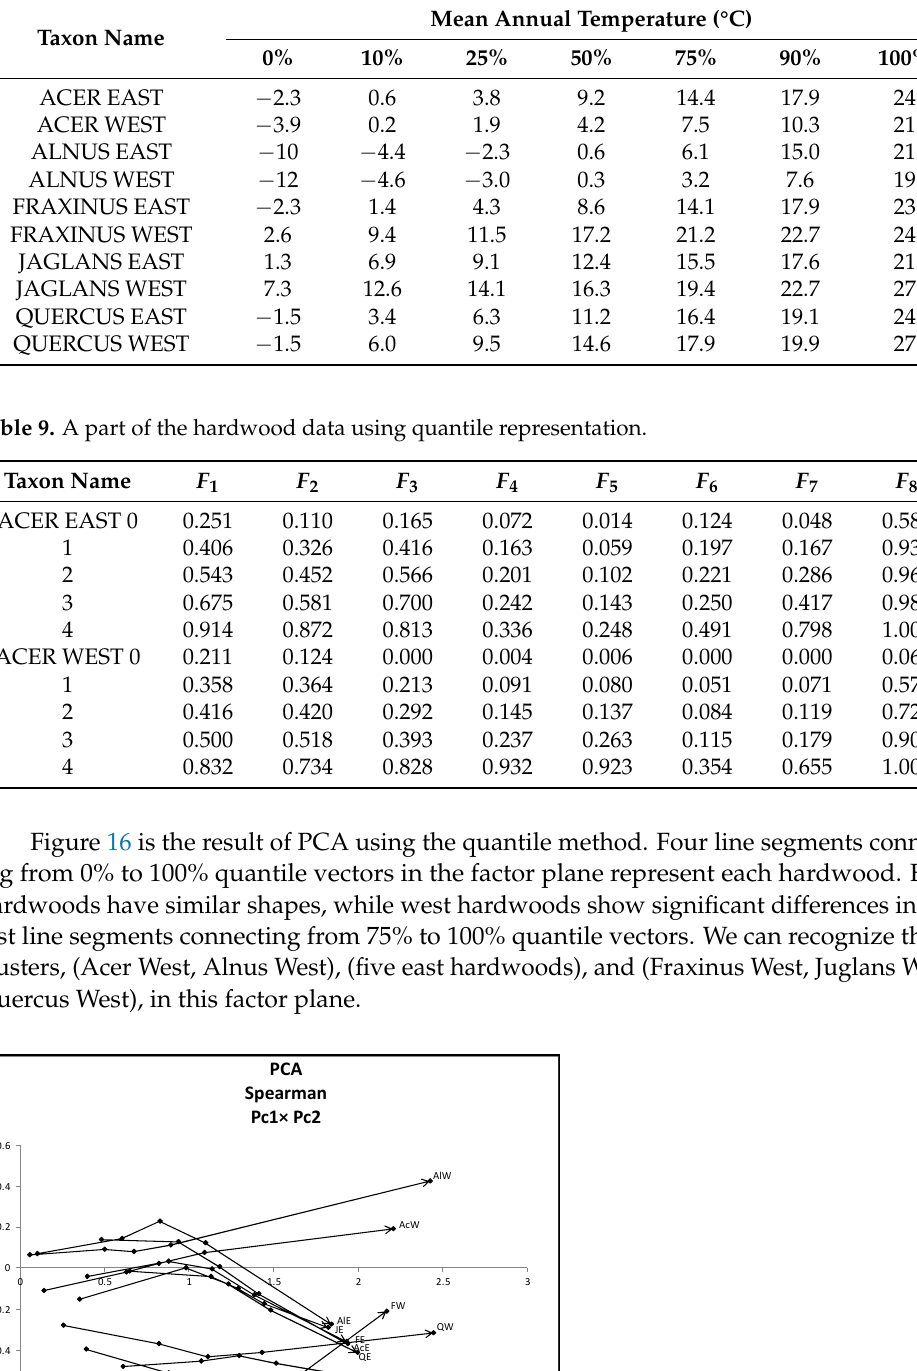
Table 8. The original quantile values for ANNT.